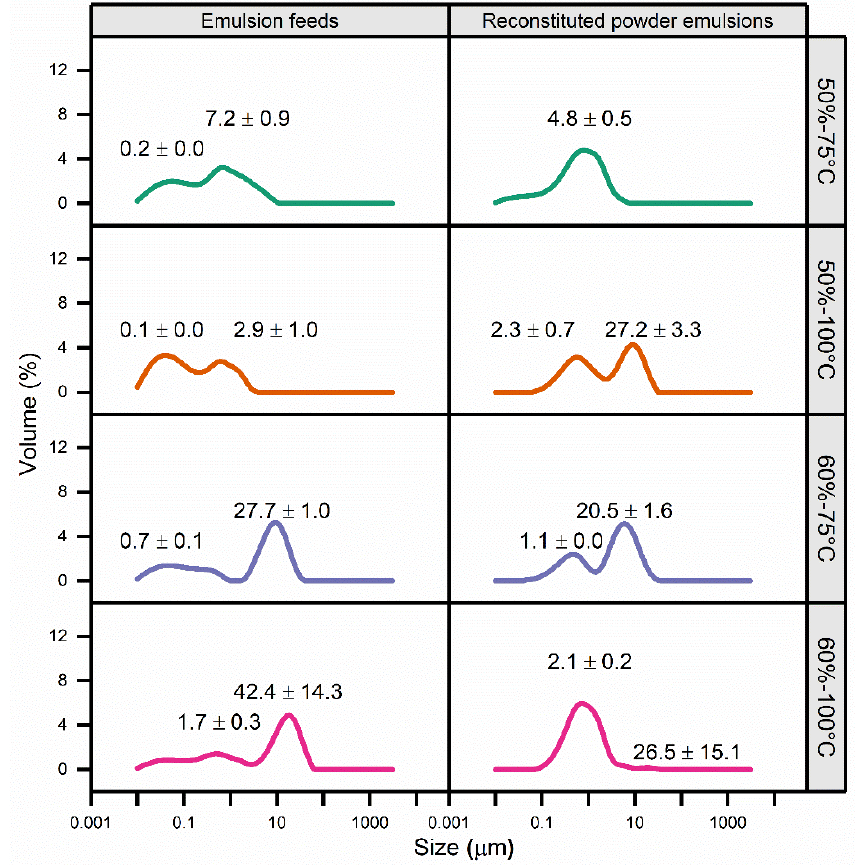
Figure 3. Particle size distribution of the emulsions, before spray drying (feeds) and after spray drying and reconstitution (reconstituted powders). Text on the graphs indicates mean D[4,3] ± standard deviation (n = 4) for each particle population within the sample.